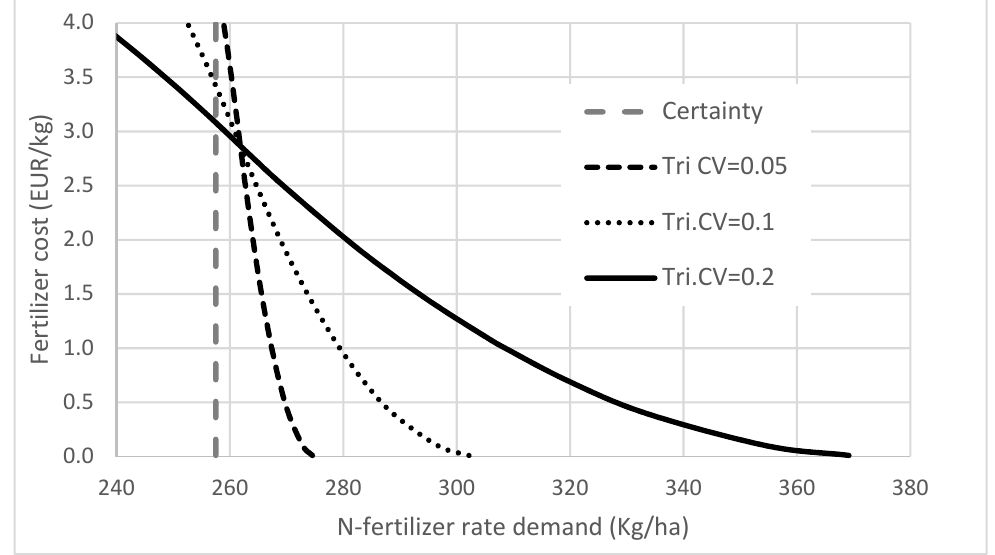
Figure 4. Effect of expected yield variability in fertilizer demand (Mean = 12,440 kg·ha − 1 ; CV = 0.05, 0.10, and 0.20) simulated from a triangular distribution (9415; 12,307; 14,795).